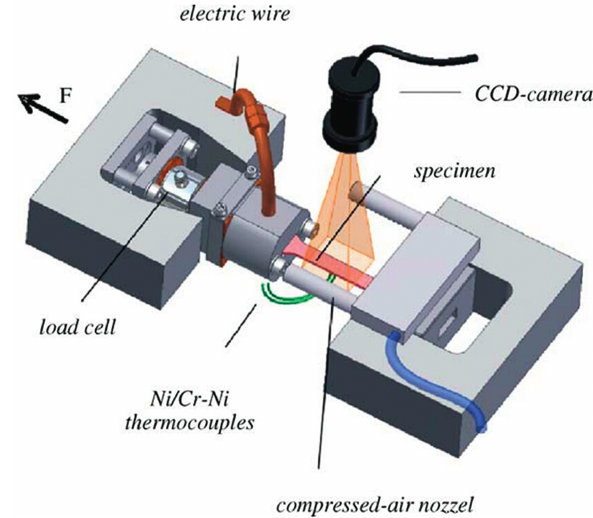
Figure 3: Schematic sketch of the modified test chamber of the servo hydraulic Gleeble 3500 mechanical system [17].